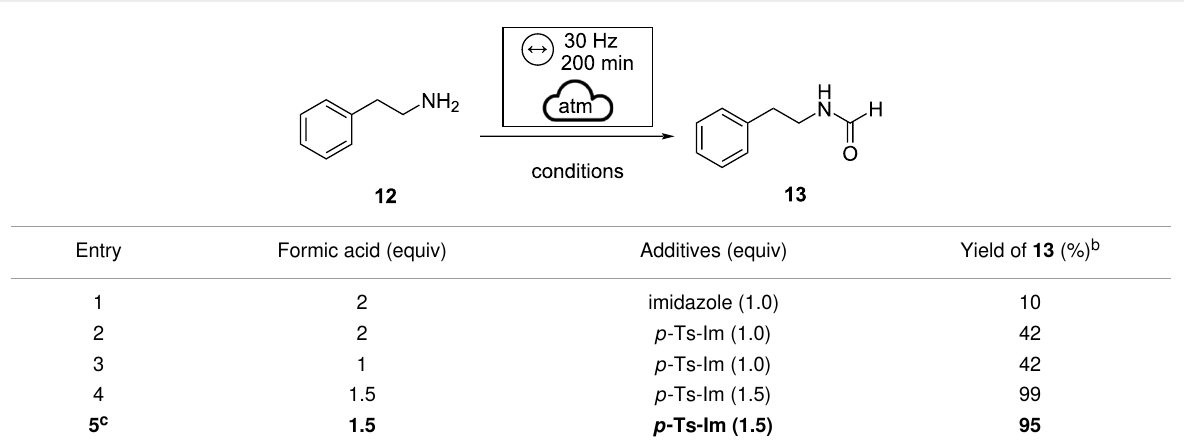
Table 2: Optimization of reaction conditions for product 13 . a